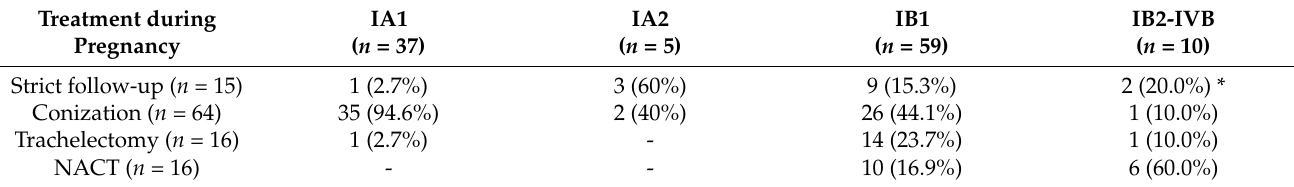
Table 2. Treatments administered during pregnancy by stage among patients diagnosed at a gesta- tional age of <22 weeks who chose to continue their pregnancy ( n =